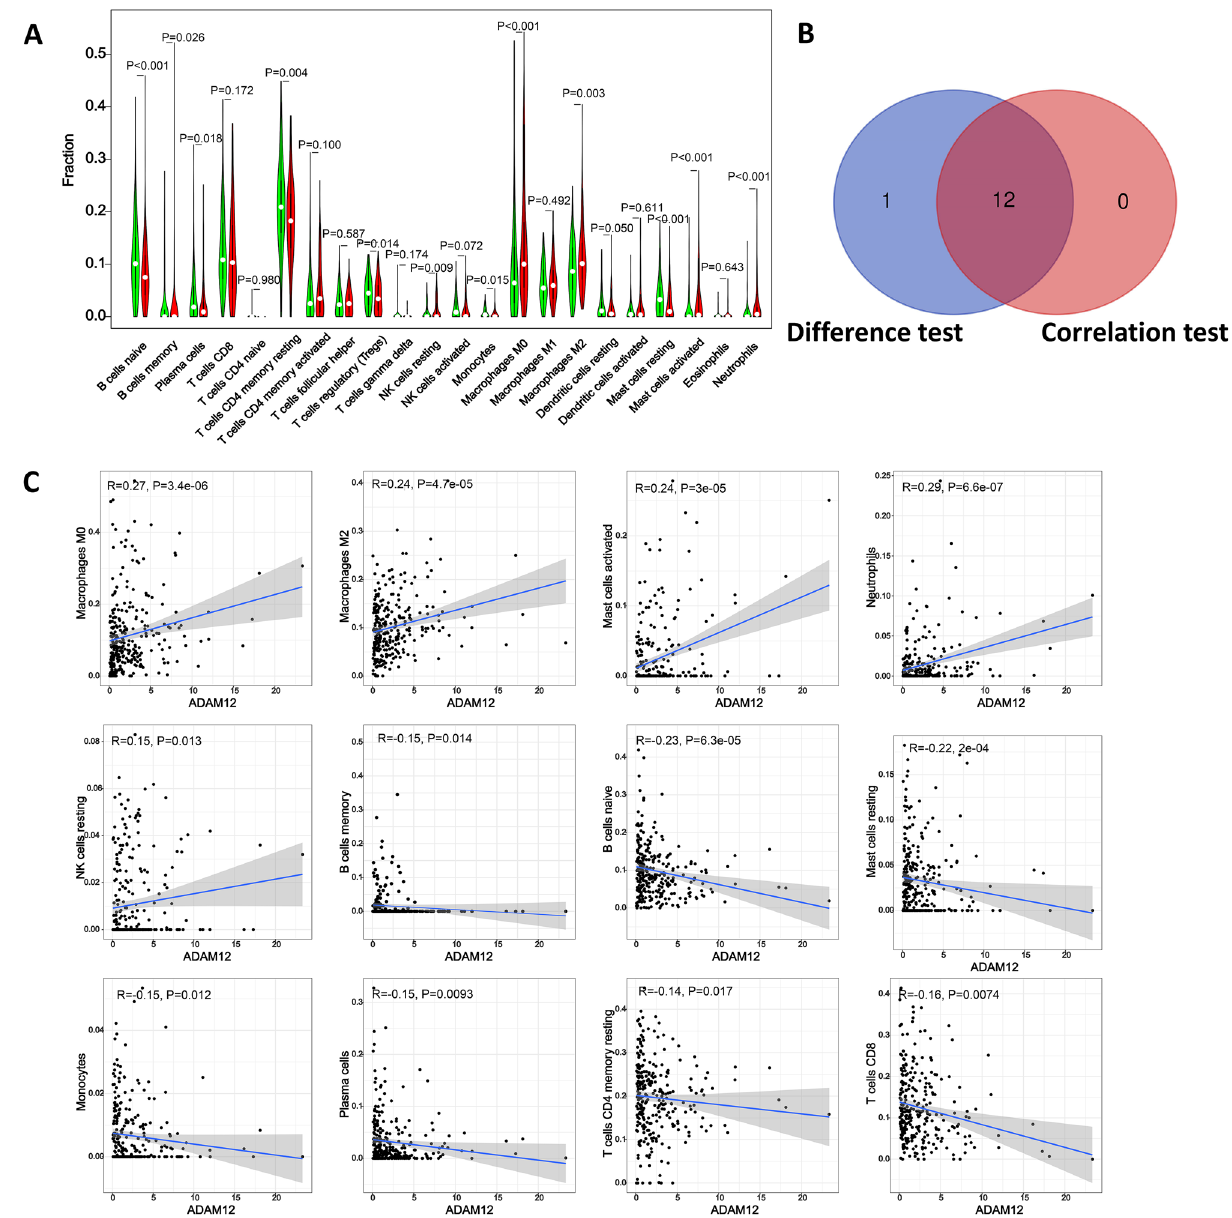
Figure 3. The association between the proportion of tumor immune cells and ADAM12 expression. ( A ) Violin plots present the ratio differentiation of 22 immune cells between gastric cancer tumor samples with low or high ADAM12 expression relative to the median ADAM12 expression level, and Wilcoxon rank sum was used for significance testing. ( B ) Venn diagram showing immune cells with significant differences and correlations with ADAM12 expression. ( C ) Scatter plots show that the proportion of immune cells in 12 tumors was correlated with ADAM12 expression (P <